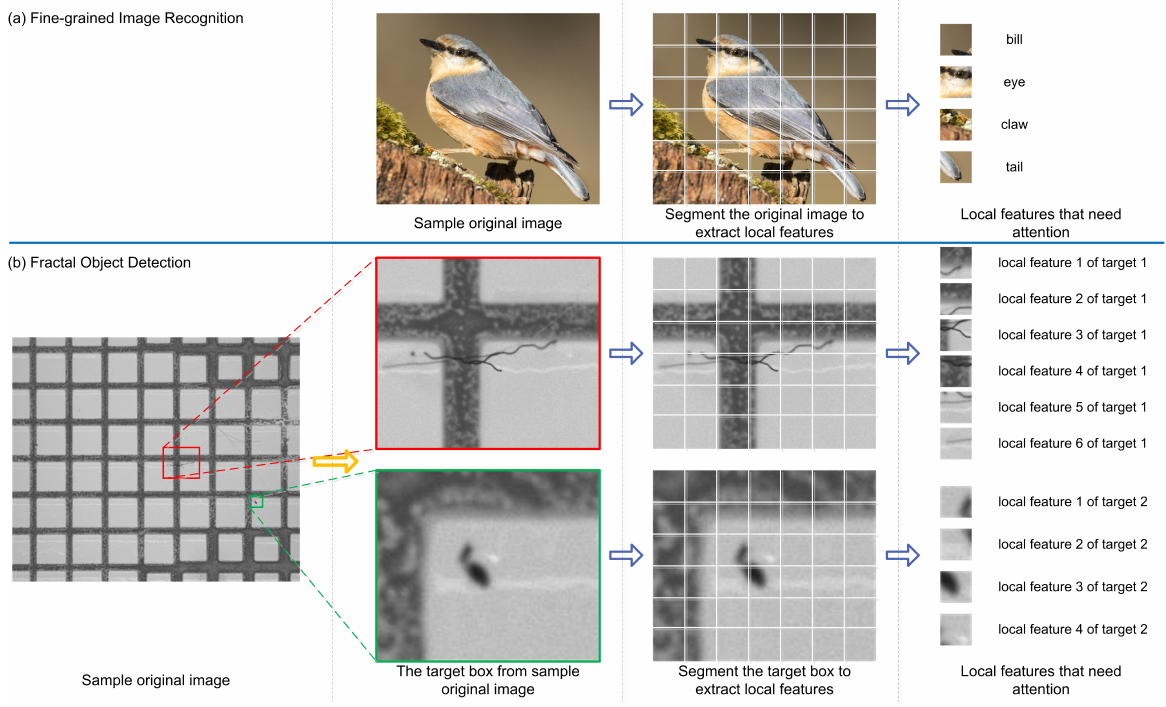
Figure 2. Fine-grained Image Recognition ( a ) and Fractal Object Detection ( b